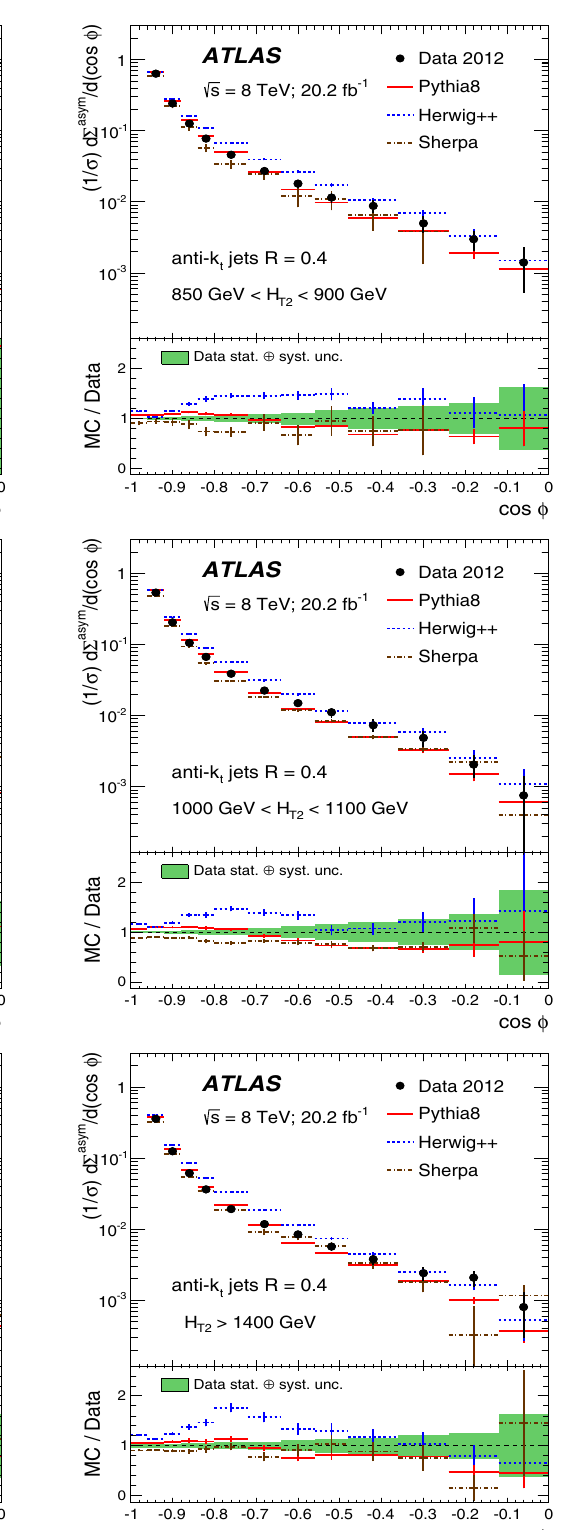
Fig. 4 Particle-level distributions for the ATEEC functions in each of the H T2 intervals chosen in this analysis, together with MC predictions from Pythia8 , Herwig++ and Sherpa . The total uncertainty, includ-